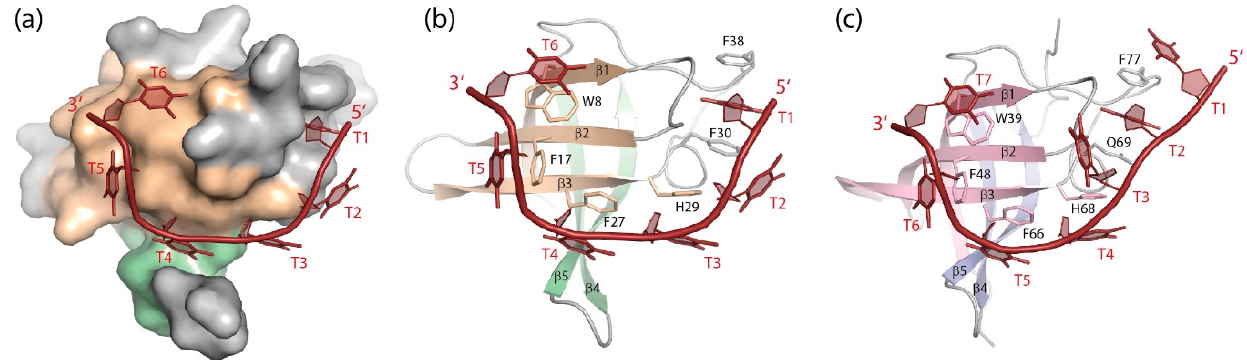
Figure 5. DNA single strands bound to CSDs. ( a ) Solvent-accessible surface and ( b ) cartoon drawing of Bc CspB bound to (dT) 6 ([113], PDB entry 2hax). Only one globular unit formed by two strands of a domain-swapped Bc CspB dimer (see